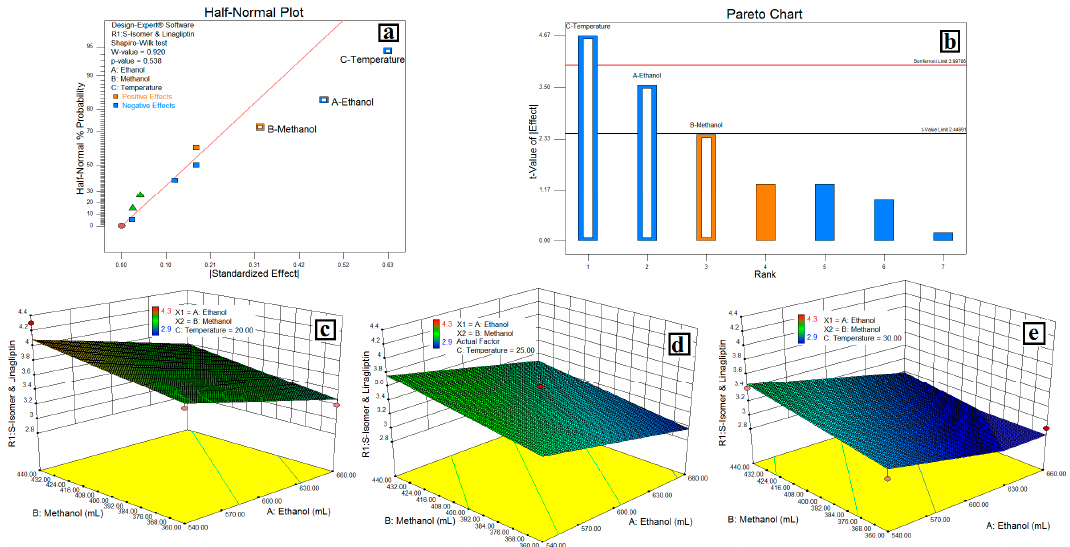
Figure 2. Relation between variables on the resolution of the S -isomer and linagliptin (LGP). ( a ) Half Normal Plot; ( b ) Pareto Chart; ( c , d and e ) 3D Plots showing the linear effect of temperature with